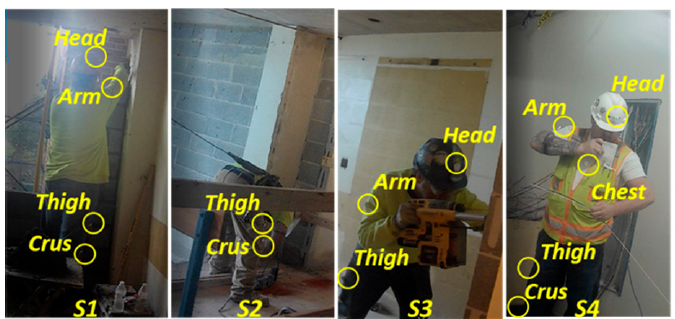
Figure 3. Subjects working with sensors (the sensors blocked are not circled) [17].